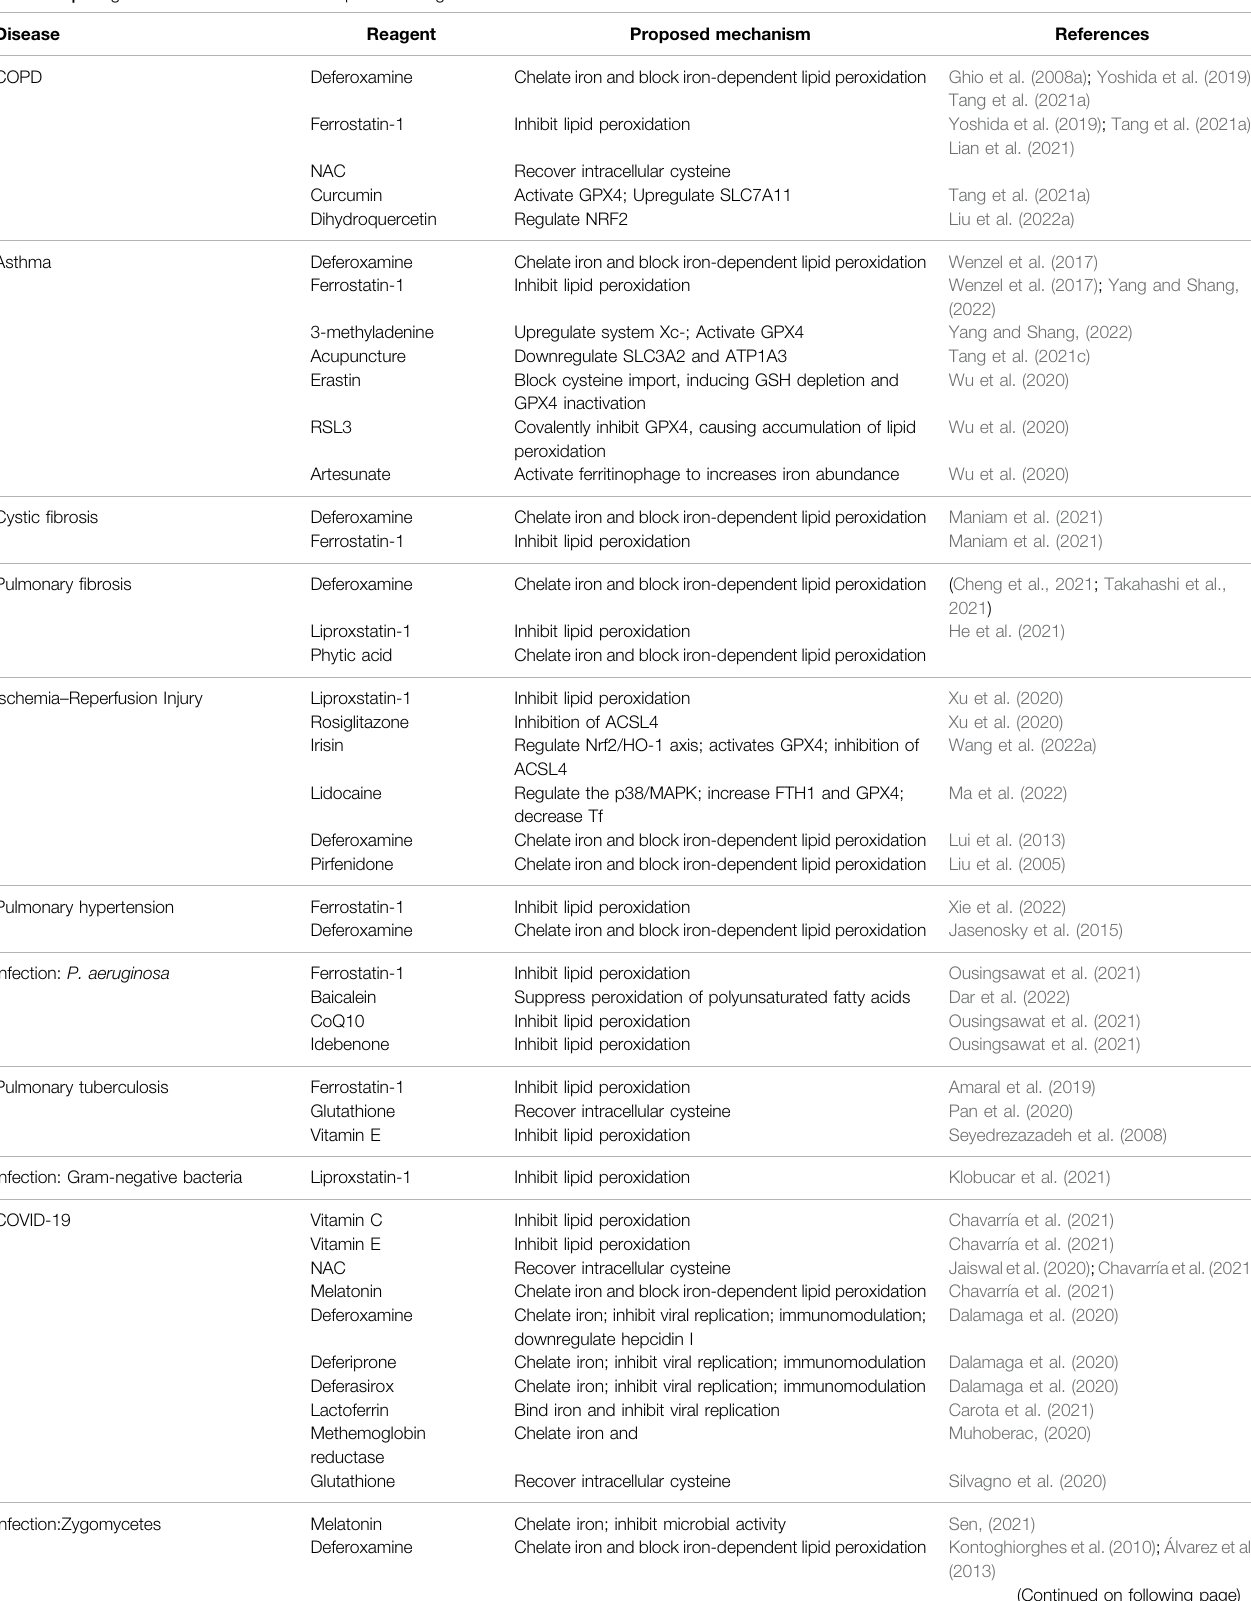
TABLE 1 | Reagents and mechanisms of ferroptosis in lung diseases.